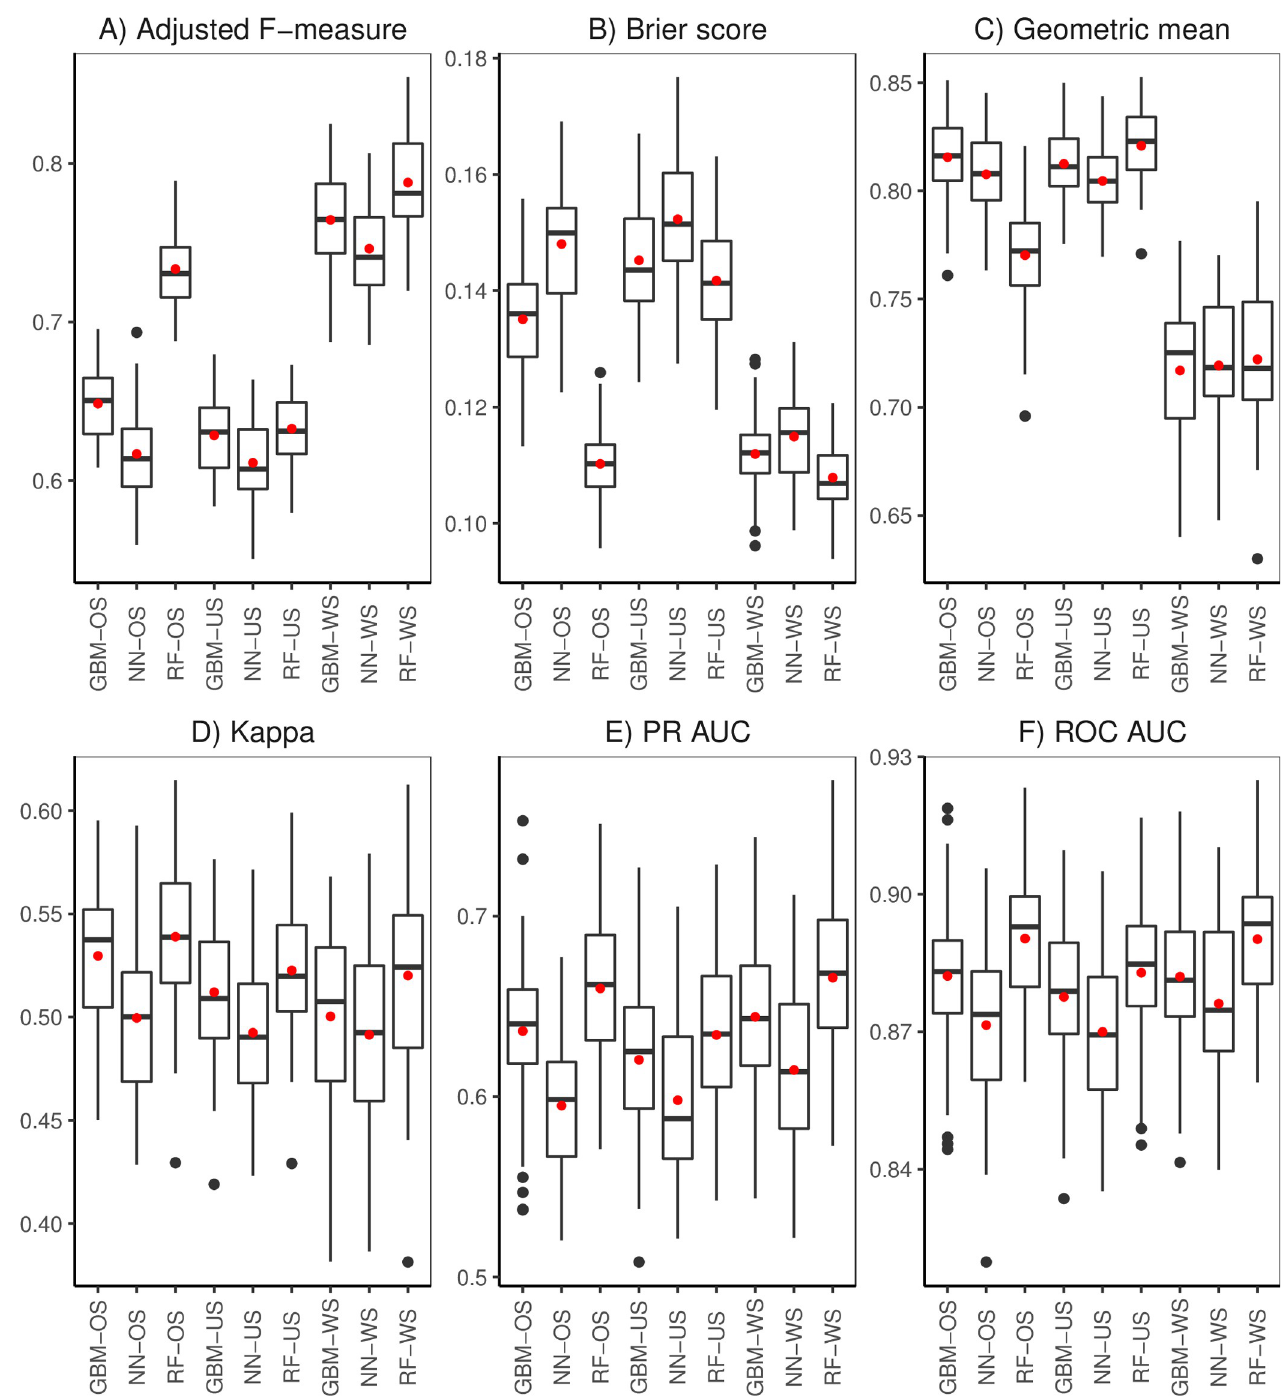
Fig 4. Performance metrics (A: Adjusted F-measure, B: Brier score, C: Geometric mean, D: Cohen’s Kappa, E: PR AUC, F: ROC AUC) for random forest (RF), gradient boosted machines (GBM) and neural networks (NN) trained on the 12 covariates chosen via subjective feature selection. Each algorithm was trained under three different sampling scenarios: Oversampling (OS), and undersampling (US) and without sampling (WS). The black line and red dot inside the box are the median and mean, respectively.